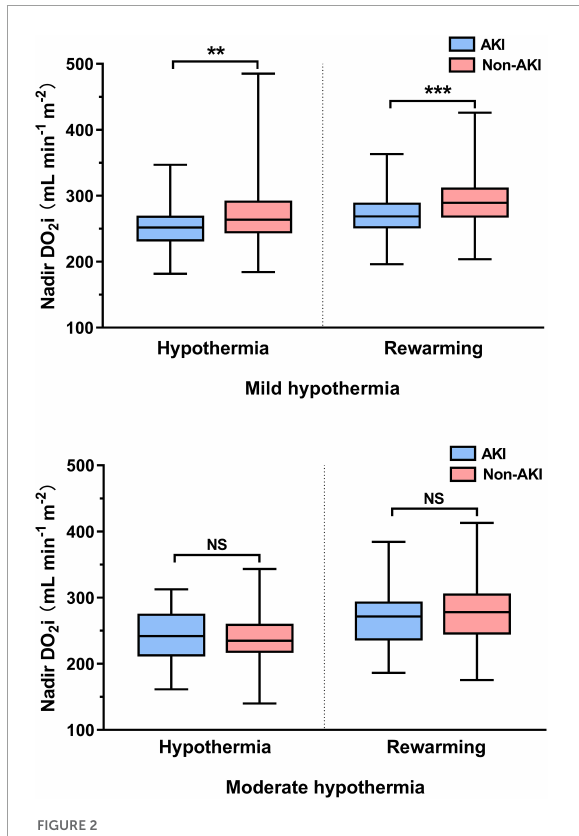
FIGURE2 Hypothermic and rewarming nadir indexed oxygen delivery (DO 2 i) in mild and moderate hypothermia. NS, not significant ( p > 0.05); ** p < 0.01; *** p < 0.001.